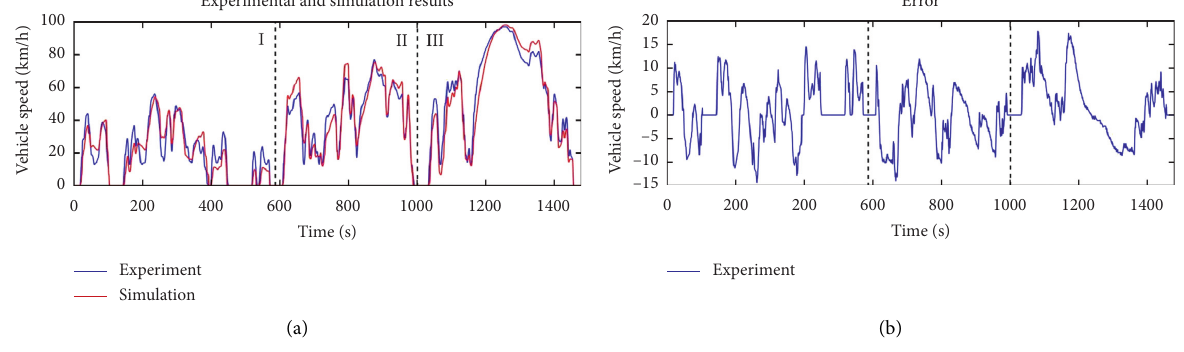
Figure 6: Speed comparison between simulation and experiment. Table 1: Comparison between simulation and experiment.